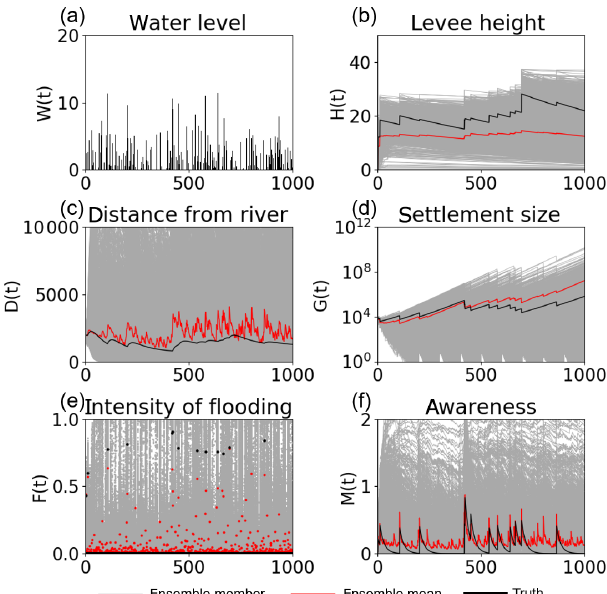
Figure 5. Time series of (a) the high water level W(t) , (b) the flood protection level (or levee height) H(t) , (c) the distance of the center of the mass of the human settlement from the river D(t) , (d) the size of the human settlement G(t) , (e) the intensity of flooding events F(t) , and (f) the social awareness of the flood risk M(t) simulated by 5000 ensembles, with uncertain high water levels and no data assimilation, in experiment 2 (see Sect. 3.1.2). The time step is an- nual. Gray, red, and black lines are the ensemble members, their mean, and the synthetic truth,